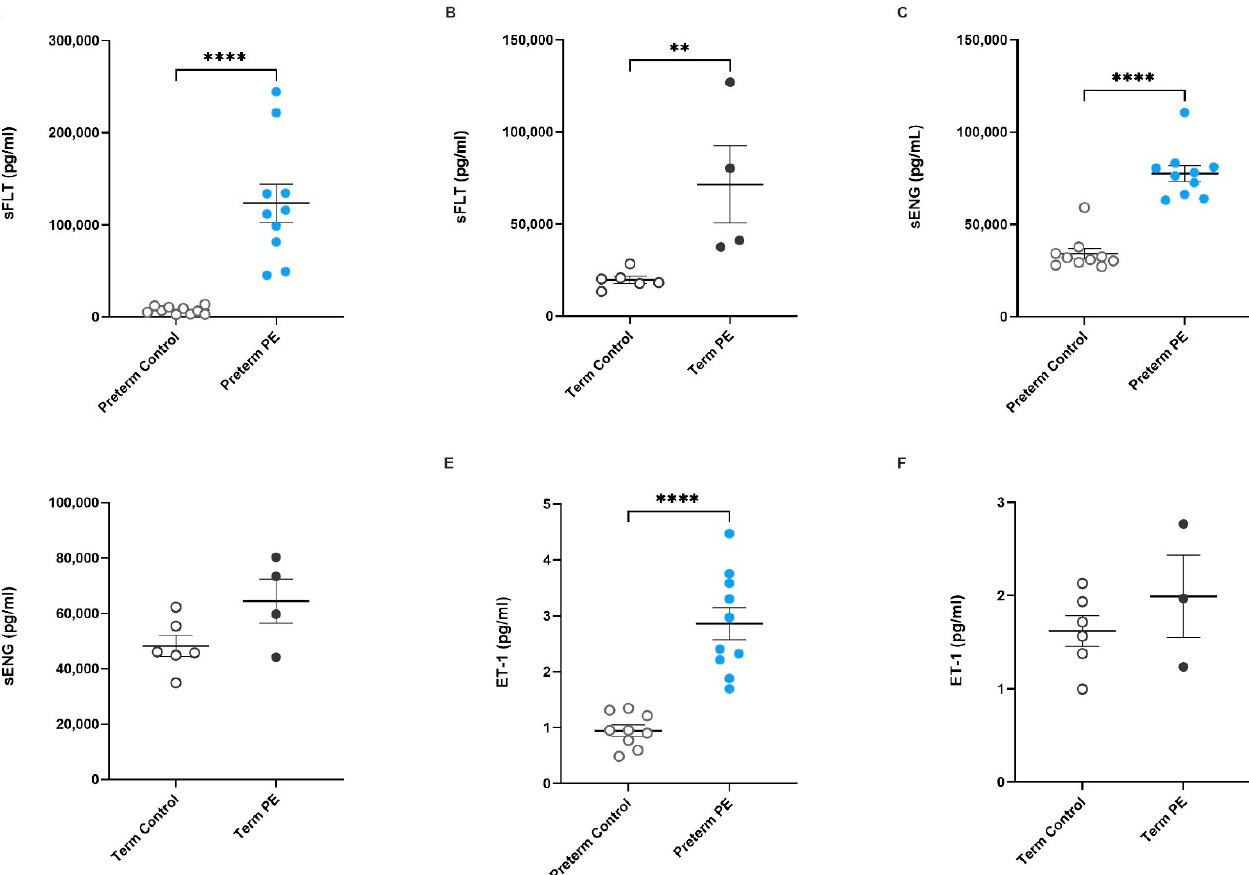
Figure 1. Antiangiogenic factors sFlt-1 and sENG, and potent vasoconstrictor ET-1, are increased in serum obtained from pregnancies complicated by preeclampsia. Circulating sFlt-1 concentrations in serum from pregnancies complicated by ( A ) preterm preeclampsia ( ) or ( B ) term preeclampsia ( ) and from patients with uncomplicated pregnancies at matched gestation (preterm and term controls; ) are shown. Circulating sENG concentration in ( C ) preterm and ( D ) term preeclamptic serum in comparison to gestation-matched controls are also presented, as well as ET-1 levels in serum collected from ( E ) preterm and ( F ) term preeclamptic pregnancies and gestation-matched controls. Individual points represent individual patients, and the data are expressed as mean ± SEM ( n = 4–10). p